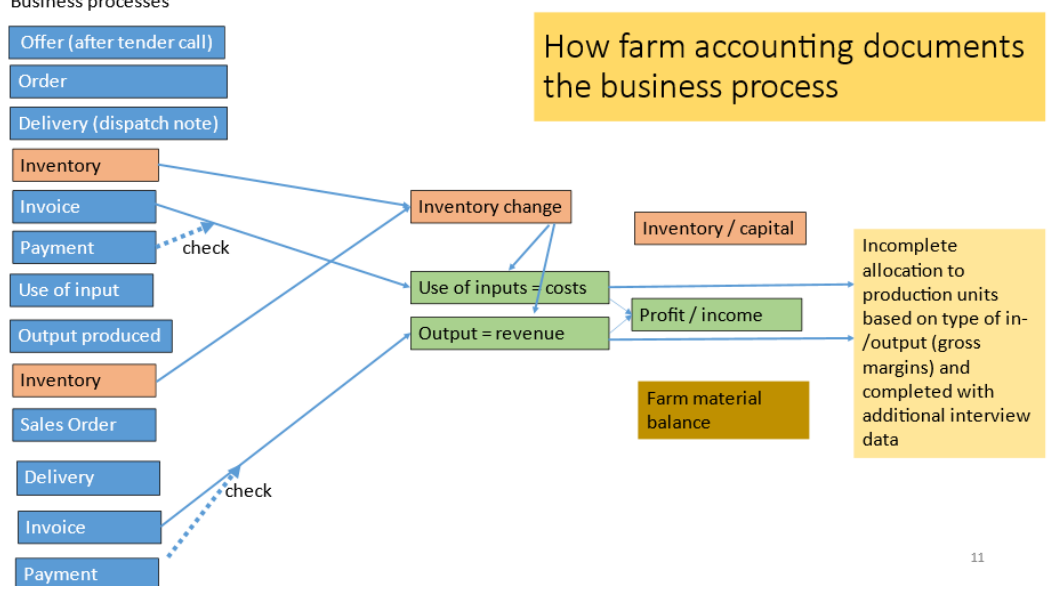
Figure 2. How Farm Financial Accounting documents the business process.